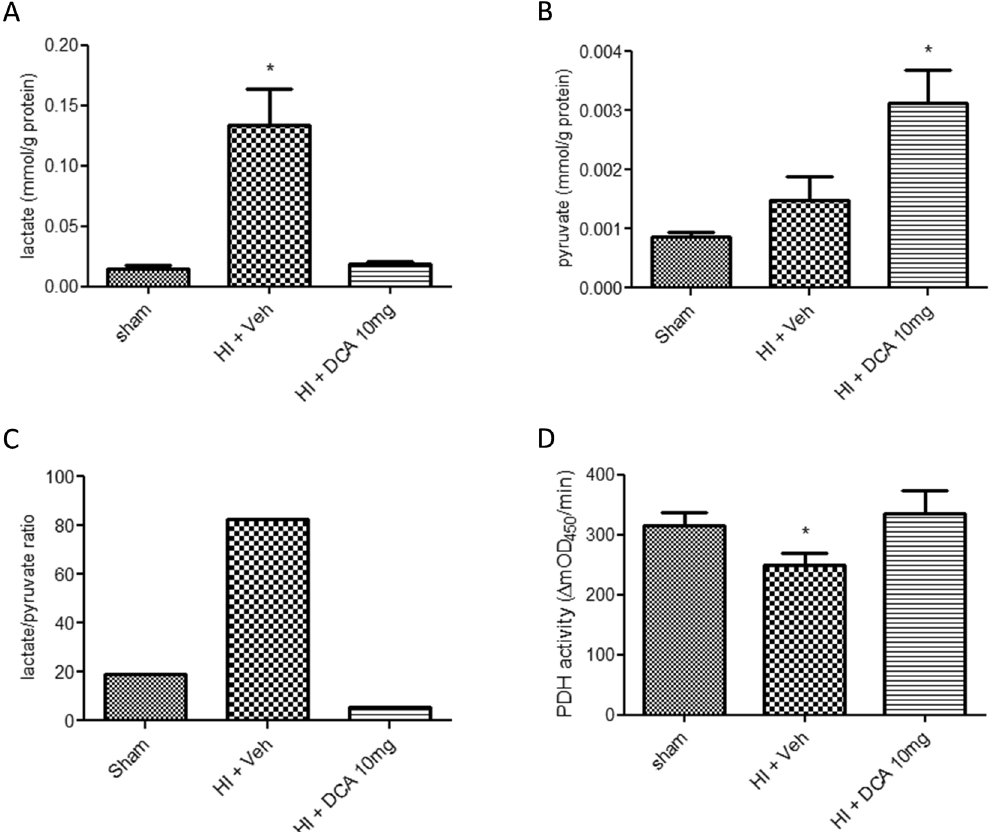
Figure 3. Plasma lactate, pyruvate and myocardial PDH. Plasma lactate ( A ) and plasma pyruvate ( B ) were measured as per manufacturers’ protocol. Results were normalized to plasma proteins to account for hemodilution. Lactate/pyruvate ratio ( C ) was calculated from the mean values. PDH activity ( D ) was measured in the heart tissue using 200 ug of total protein. All samples were tested in duplicates. Groups: Sham, HI + Veh, HI + DCA 10 mg. Bars indicate mean ± SEM. * Indicates p < 0.05 vs